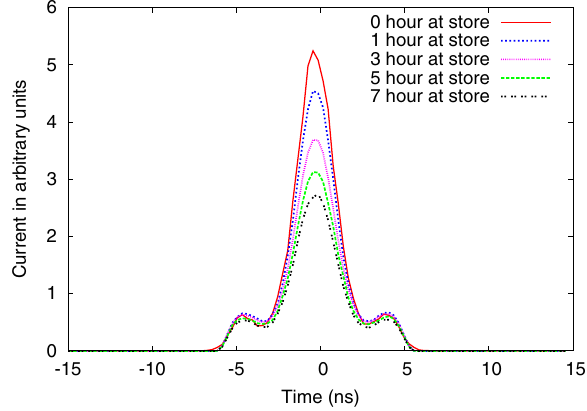
FIG. 17. Longitudinal bunch profiles at store from multiparticle simulation with 300 kV 197 MHz rf cavities. Momentum aperture 6 × 10 − 4 is